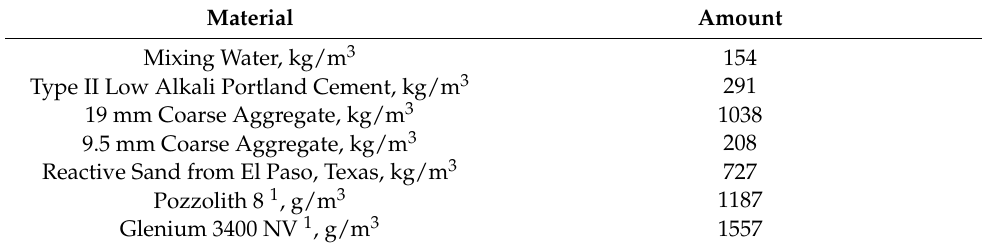
Table 3. Concrete mixture proportions.